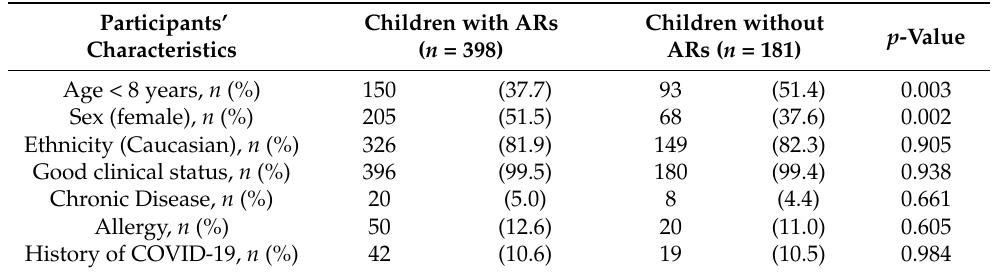
Table 2. Univariate analysis of the participants who presented with ARs compared to those without ARs following BNT162b2